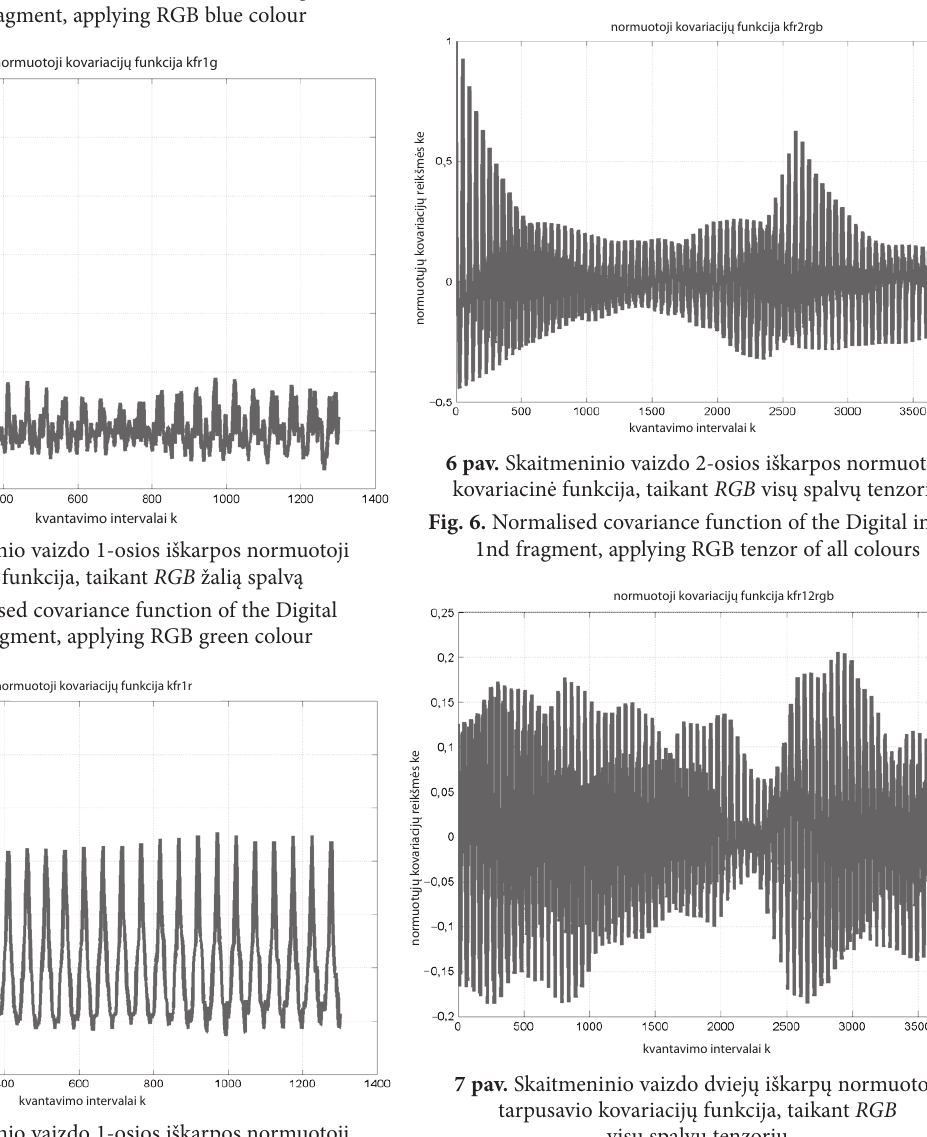
Fig. 7. Interrelation normalised covariance function of the Digital image of two fragments, applying RGB tenzor of all